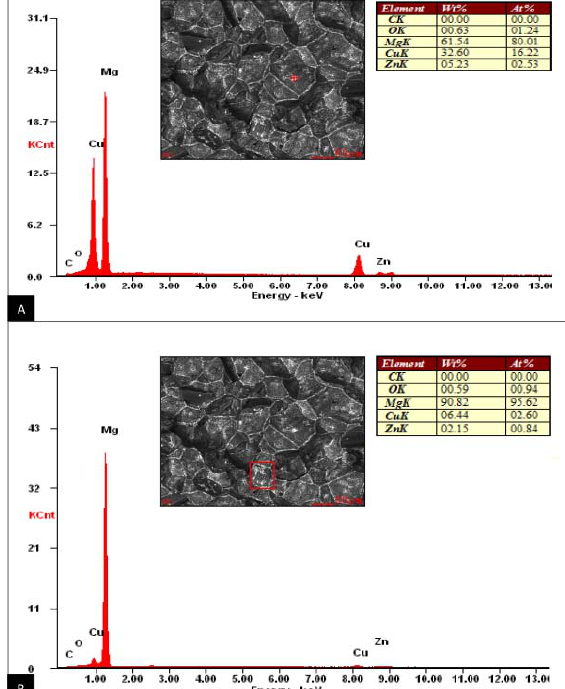
Figure 5. Mg-Zn-Cu alloy with normal failure showing Cu along boundaries of failure.